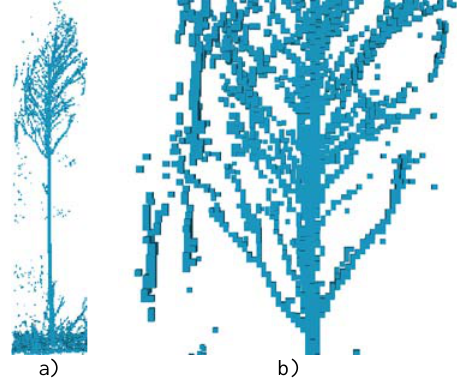
Figure 3. Voxel space representation of raw point cloud.